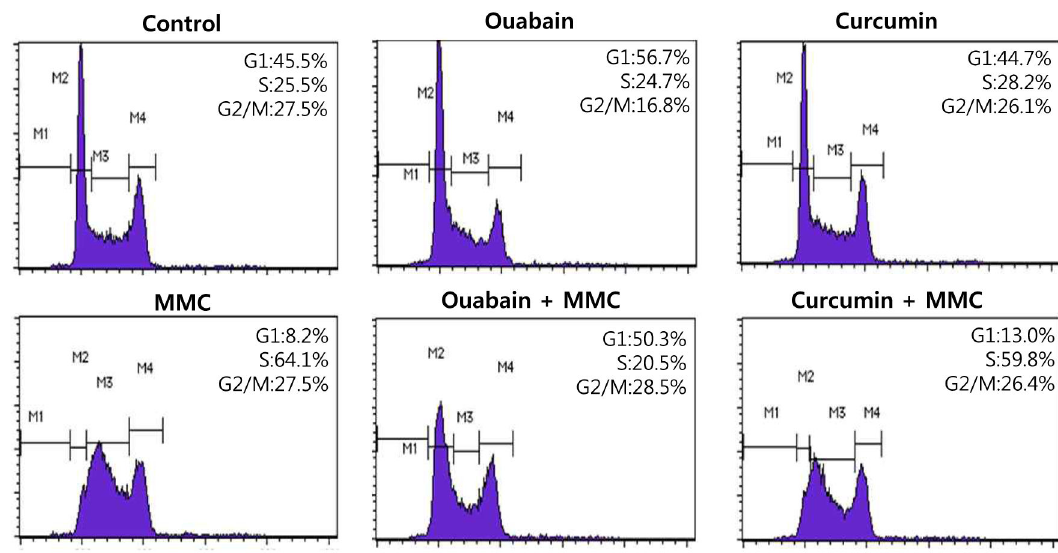
Figure 3. Ouabain disturbed MMC-induced S phase arrest. U2OS cells were pretreated with 50 nM ouabain or 5 µM curcumin for 1 h and then incubated with 200 ng/ml MMC for 24 h. After incubation, the cells were fixed, stained with propidium iodide, and subjected to flow cytometric DNA content analysis. Representative DNA content profiles from three independent experiments are